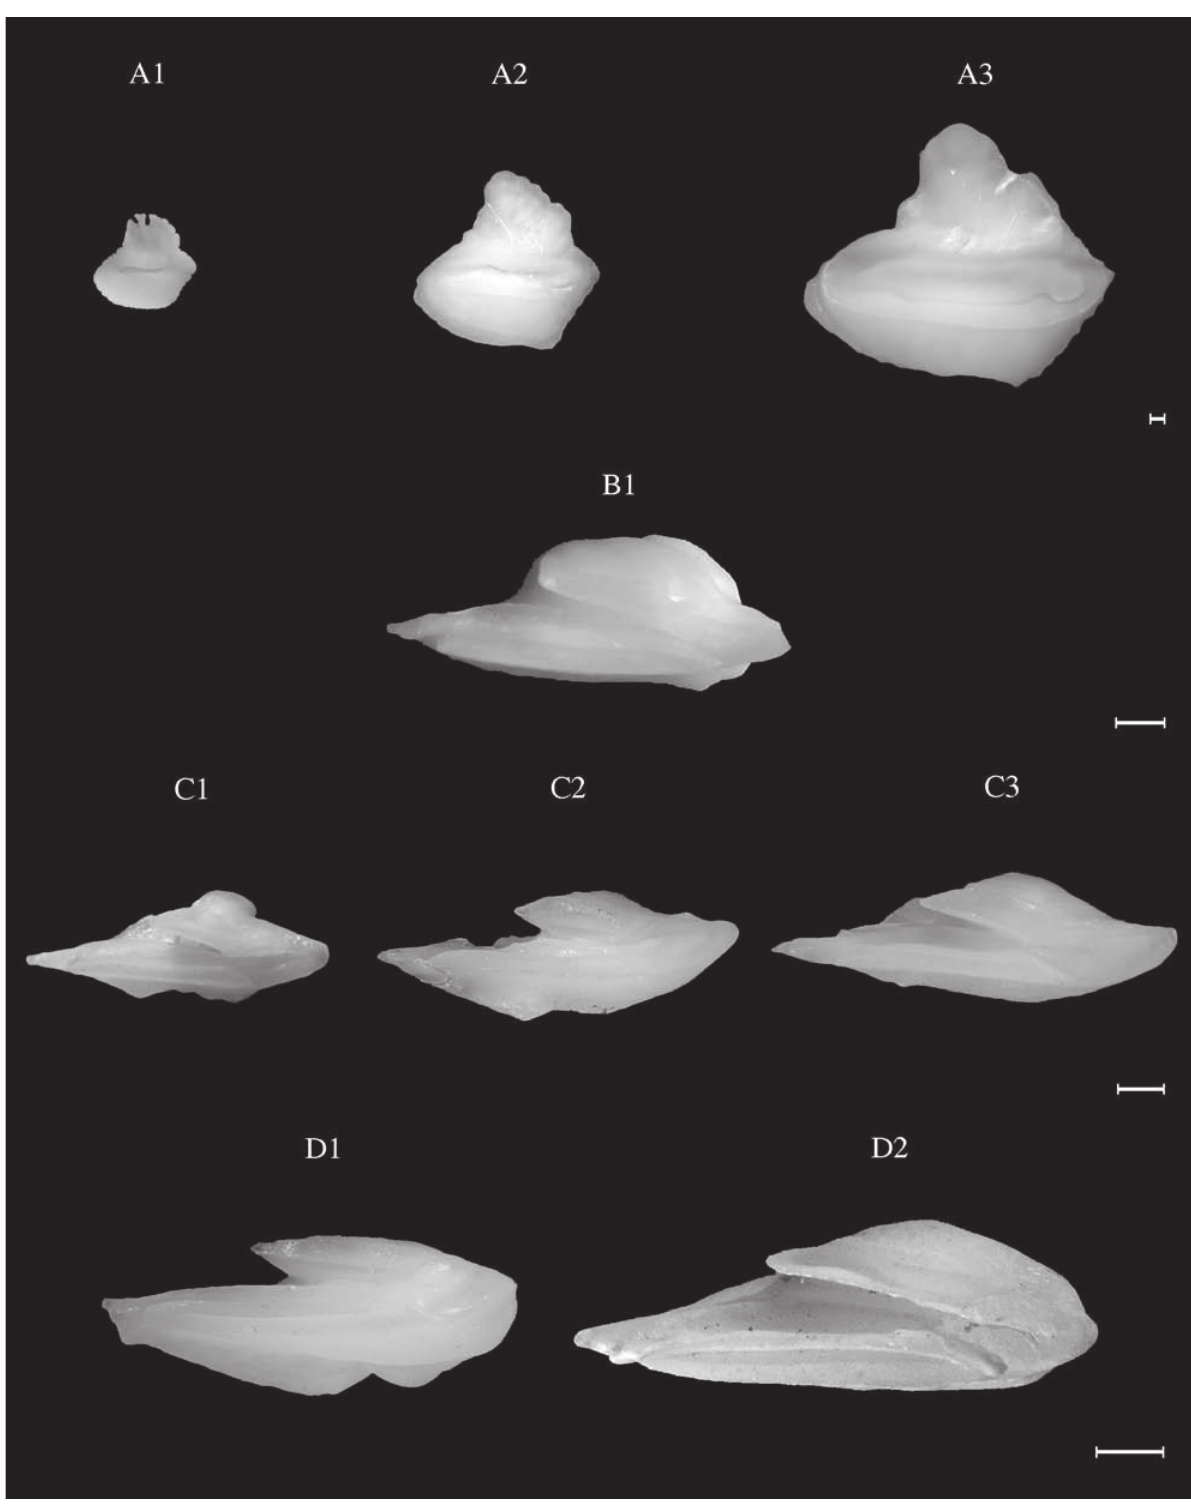
Fig. 27. – Trachyrincus scabrus . PL: A1, 6.2 cm (NEA); A2, 11.5 cm (WM); A3, 20.0 cm (WM) Antimora rostrata (CEA). TL: B1, no data available. Gadella maraldi . TL: C1, 9.0 cm (WM); C2, 14.6 cm (CEA); C3, 17.8 cm (NEA). Laemonema yarrellii (CEA). TL: D1, 11.6 cm; D2, 14.1 cm. Scale bar = 1